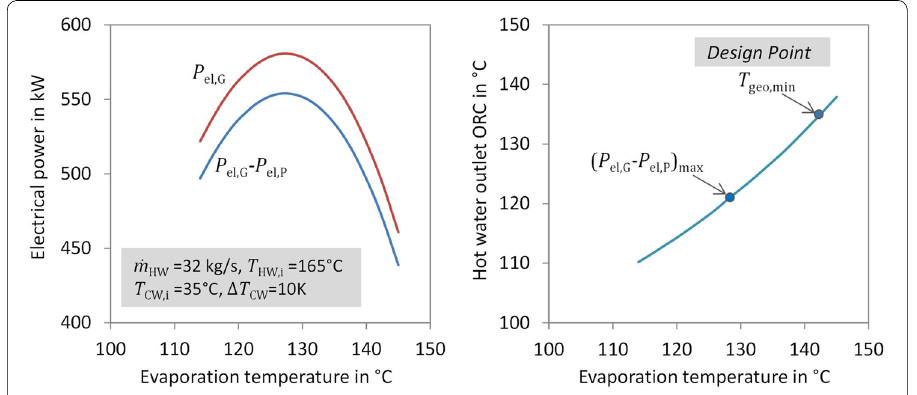
Fig. 4 Electrical power (left) and hot water outlet temperature (right) depending on the evaporation